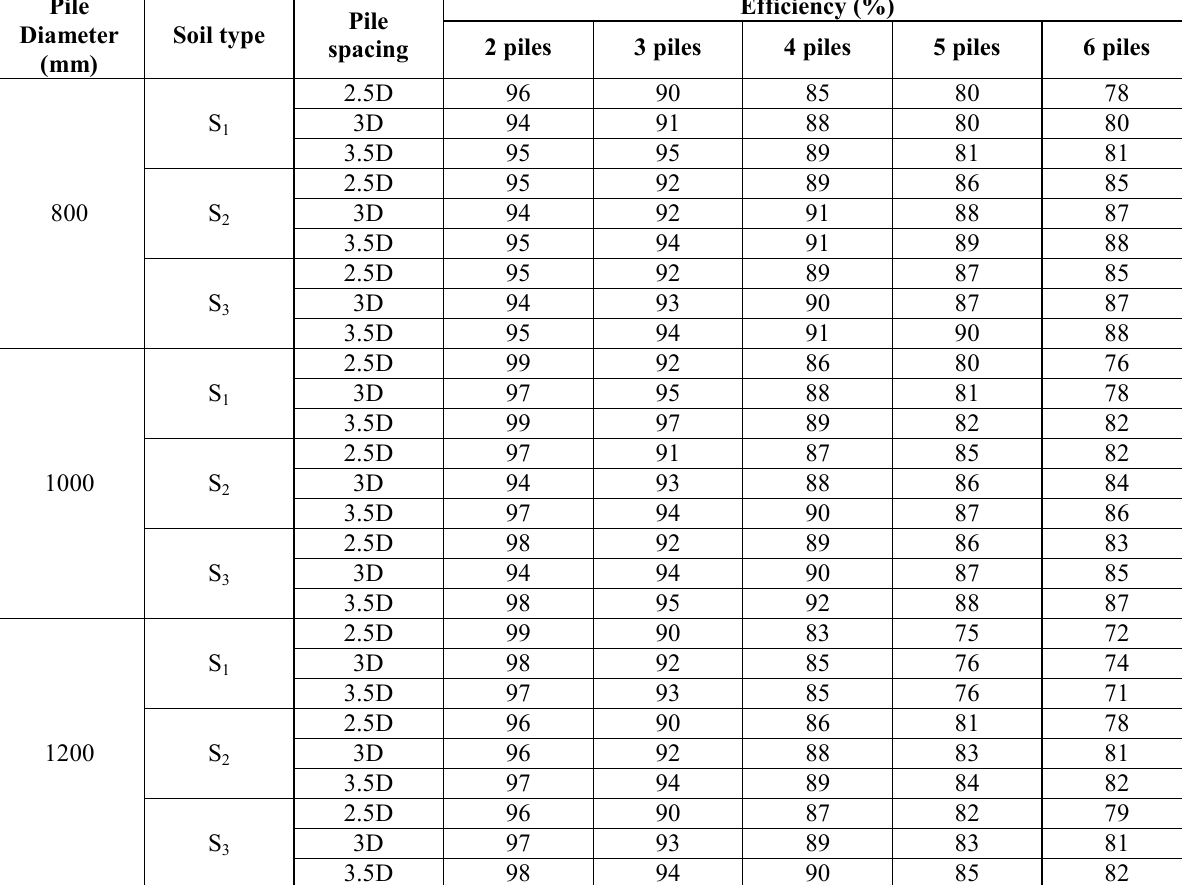
, D , D at different spacing under three soil types. 800 1000 1200